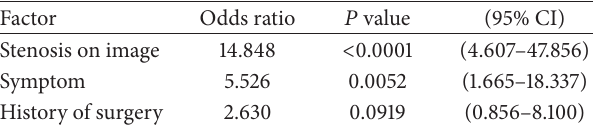
Table 7: Factors affecting the role of DBE—multivariate analysis.